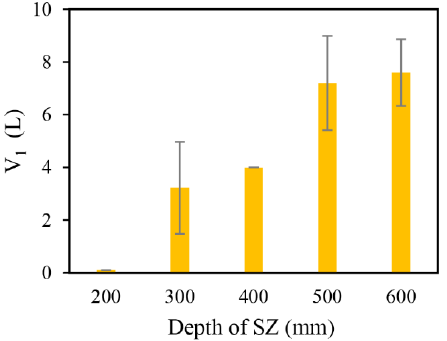
Figure 9. Variations in V 1 with the depth of SZ (data source: effluent runoff nitrogen concentration of six bioretention systems with different depths of SZ by Wang et al. [25] ). The bars represent the mean value of V 1 , and the error lines represent the standard deviation of V 1 .